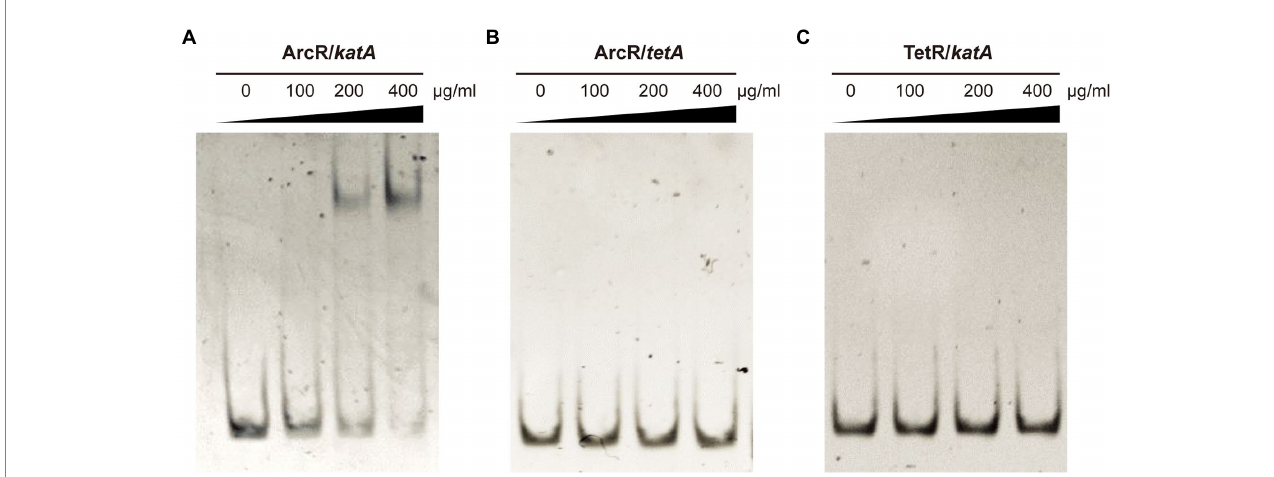
FIGURE 6 ArcR promotes expression of katA by directly binding to its promoter region. Interaction between ArcR and katA promoter region was examined by EMSA. ArcR was incubated with katA promoter region (A) , ArcR was incubated with tetA promoter region (B) , and TetR was incubated with katA promoter region (C) at 37 ° C for 30 min. The mixtures were electrophoresed on agarose gels and the bands were visualized under UV light after ethidium bromide staining. The data represent results from three independent